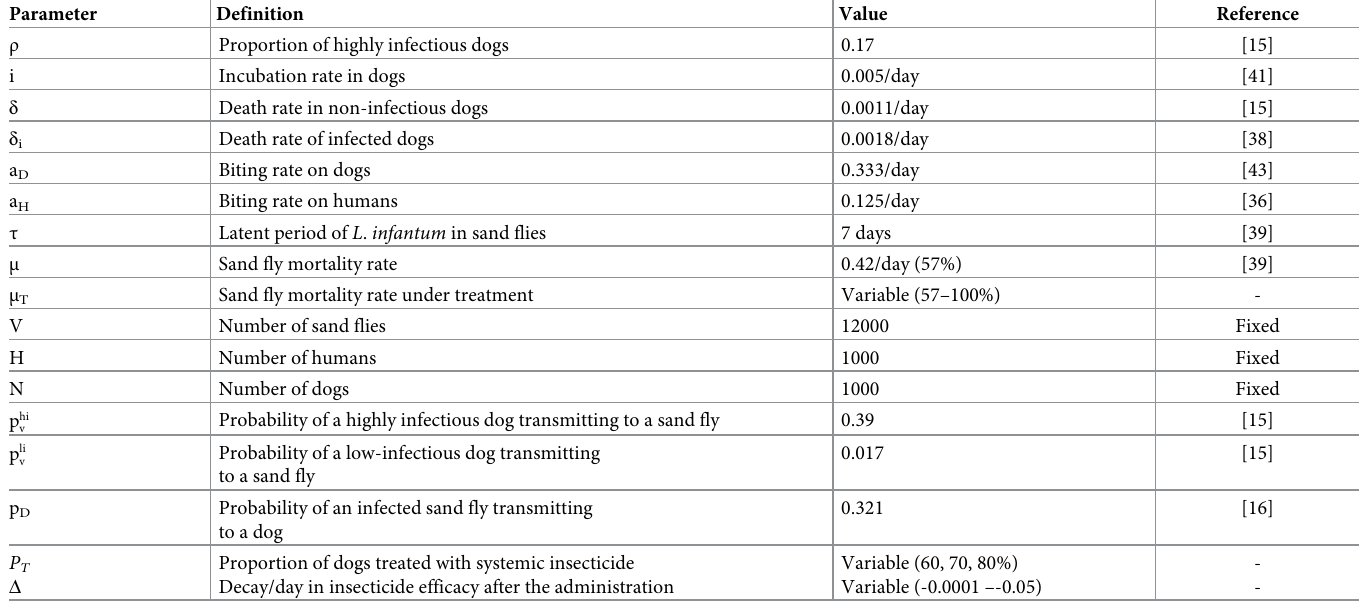
Table 1. Parameters in the model and their